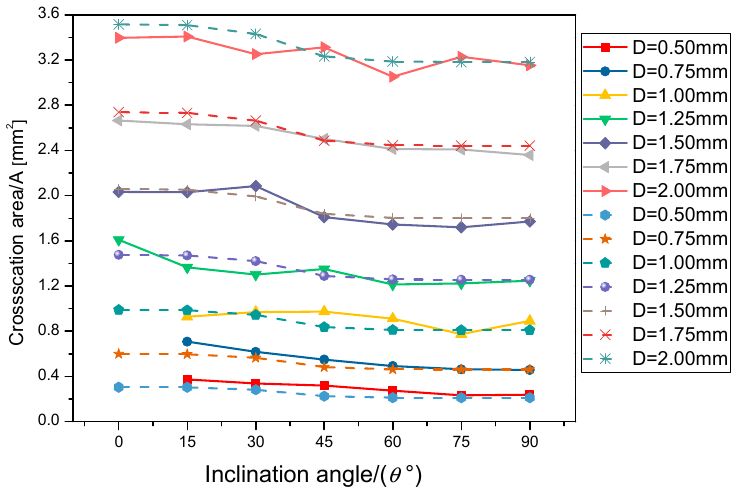
Figure 15. Comparison of measured values and calculated values. Solid line represents the measured value and dash line represents calculated value.